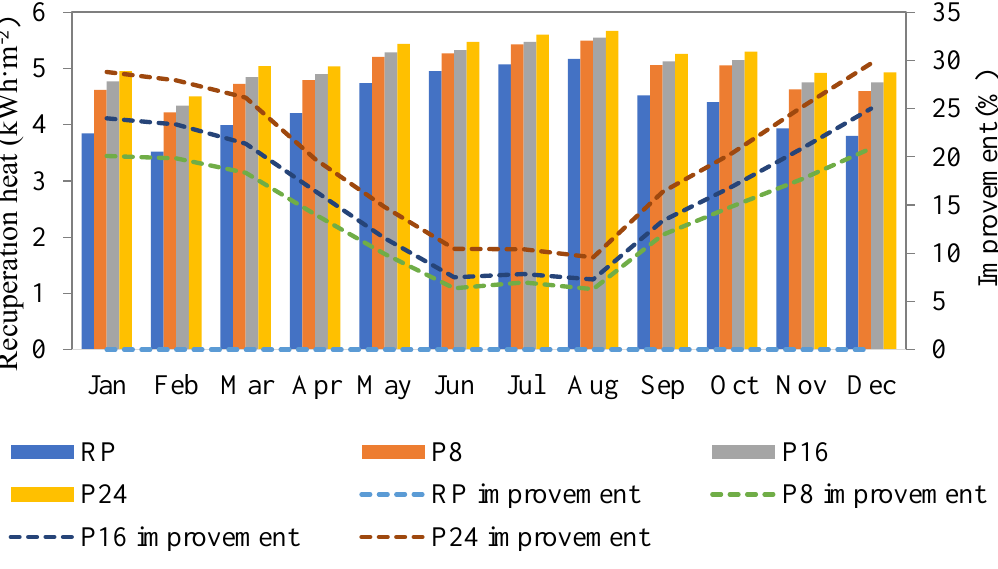
Figure 8. Monthly benefits associated with the utilization of recuperation heat in Šerák. Table 5. Annual recuperation heat produced by FSPCM plaster on ceramic brick wall with mineral wool insulation.